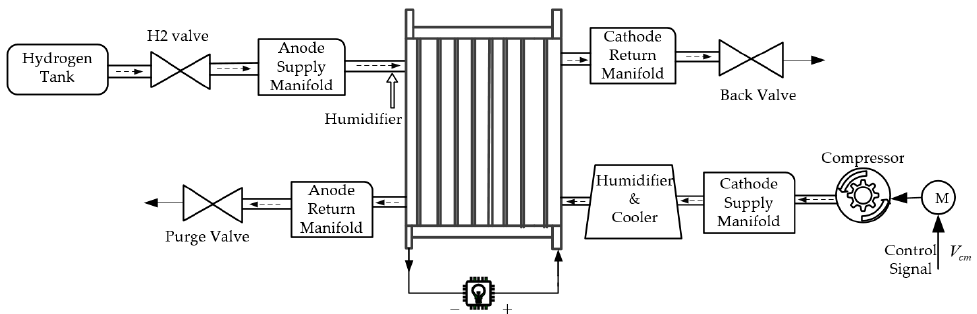
Figure 1. PEMFC system composition diagram.